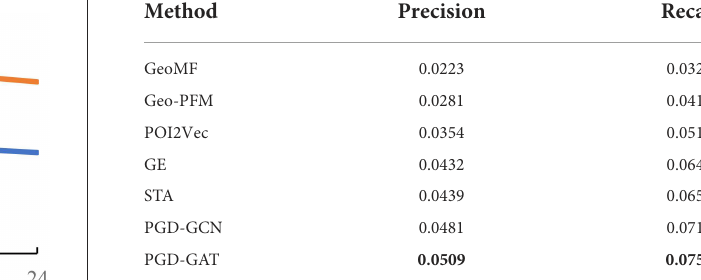
TABLE 2 Results of all methods on Yelp.